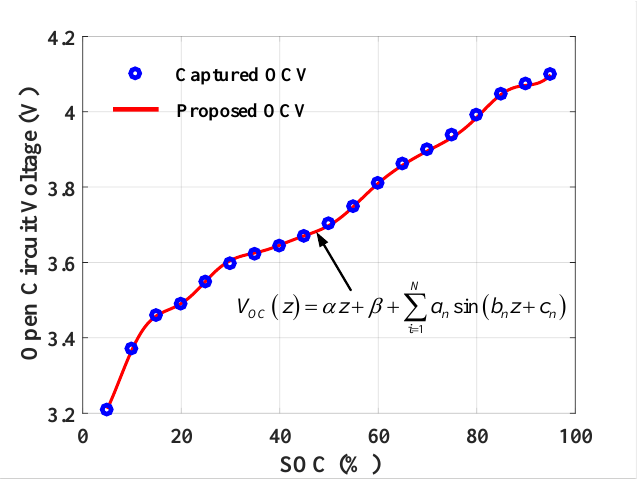
Figure 8. Captured OCV at each SOC point and the SOC-OCV curves fitted using the proposed OCV